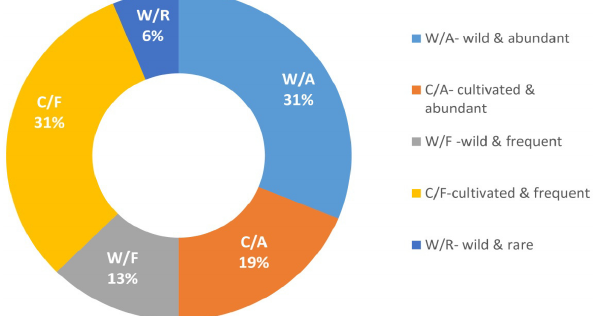
Fig. 2. Conservation status of antimalarial plants found in Jonai,